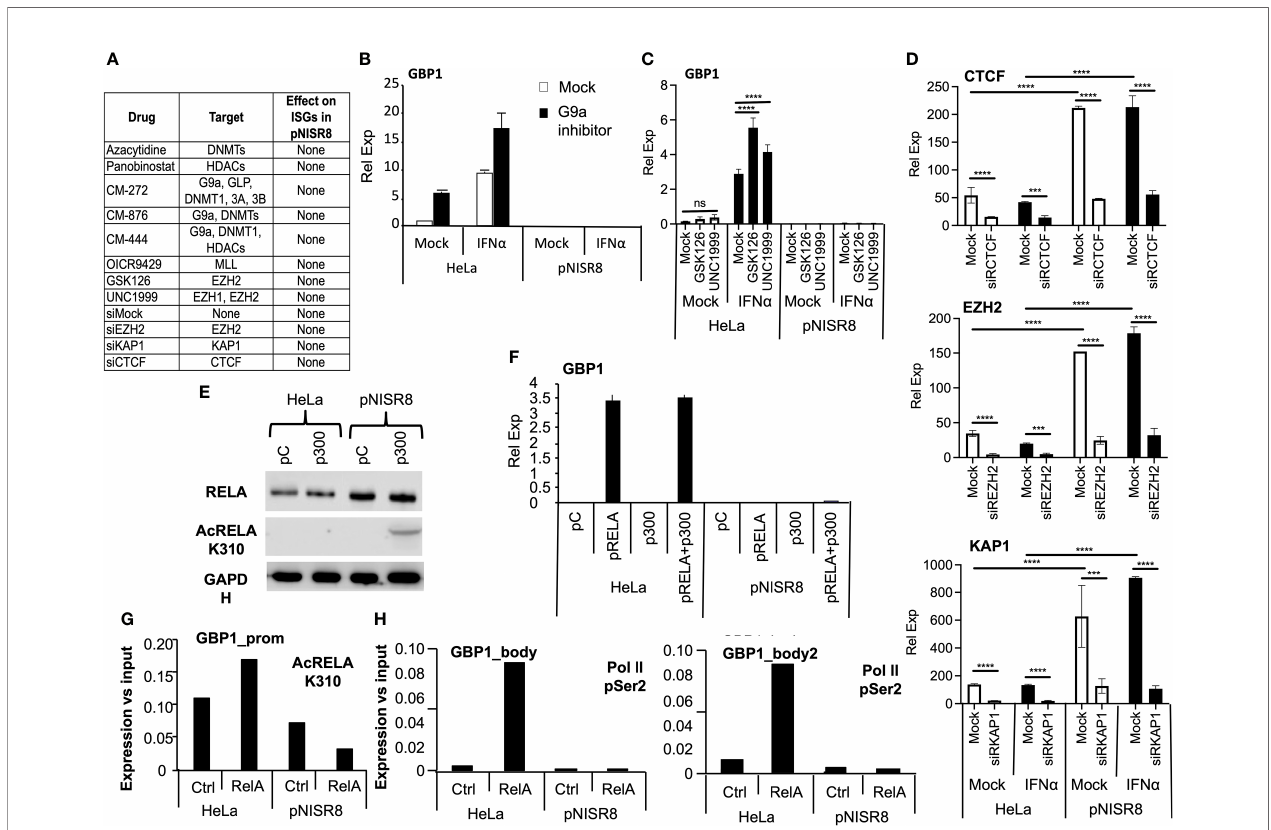
FIGURE 6 | Effect of silencing inhibitors or enhancer overexpression in ISR8 -disrupted cells. (A) Table with all the inhibitors tested, their targets and their effect over ISG levels in IFN a treated pNISR8 cells. (B, C) HeLa and pNISR8 cells were mock-treated, incubated with IFN a , and treated with G9a inhibitors (B) or the indicated EZH2 inhibitors. GBP1 mRNA levels were evaluated by qRT-PCR. (D) HeLa and pNISR8 cells were transfected with control siRNAs (Mock) or siRNAs targeting CTCF, EZH2 or KAP1. Six hours prior harvest, cells were treated or not with IFN a . Forty-eight hours after transfection CTCF, EZH2 or KAP1 mRNA levels were evaluated by qRT-PCR. (E) HeLa cells were transfected with a control plasmid (pC) or a plasmid expressing p300 and 48h later, total and acetylated RELA was evaluated by Western-blot. GAPDH was also visualized as a loading control. (F) HeLa and pNISR8 cells were transfected with a control plasmid (pC), a plasmid expressing p300 and/or pRELA. Forty-eight hours later GBP1 mRNA levels were quanti fi ed by qRT-PCR. GAPDH mRNA was also evaluated and used as a reference. (G,H) HeLa and pNISR8 cells weretransfected with a control plasmid (Ctrl) or a plasmid expressing RELA. Forty-eighthours later ChIP experiments were performed with anti-K310 acetylation RELA (G) oranti Ser2 phosphorylation Pol II antibodies (H) . Immunoprecipitated DNA was PCR ampli fi edwith primers fromthe GBP1 promoter (G) or the gene body (H) . Error barsindicate standarddeviations. Experiments were performed at leasttwice and a representative fi gureis shown. Statistical analysisis shownfor relevant